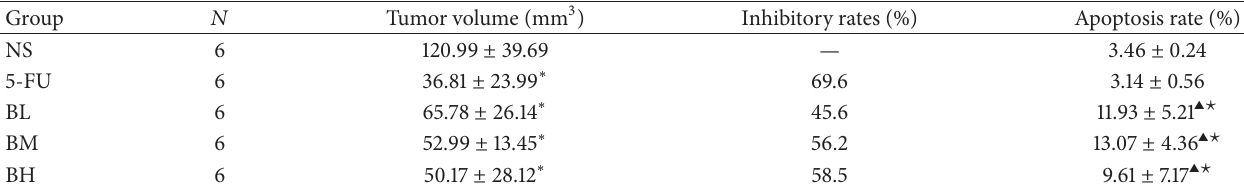
Table 1: Tumor volumes, inhibitory rate, and apoptotic rate in xenograft tumor.